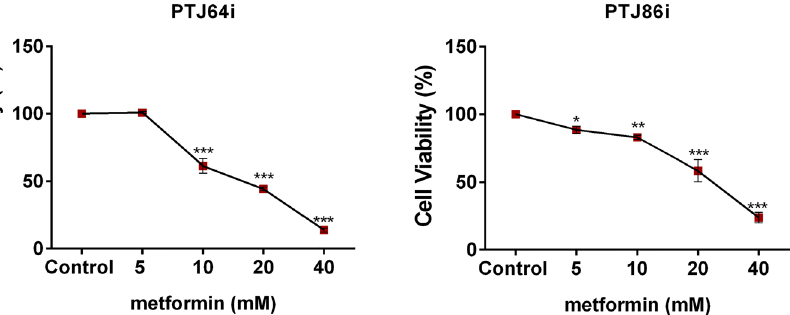
Figure 7. Metformin affects cell viability in PTJ64i and PTJ86i cell lines. Cells were incubated for 72 hours with metformin at the indicated concentrations, or with PBS vehicle (control). Cell viability was assessed by MTT assay. Metformin significantly inhibited cell viability in both cell lines in a dose-dependent manner, with an IC 50 of 21.6 mM in PTJ64i and 22.1 mM in PTJ86i, as assessed by CompuSyn. Data shown are the means ± SD of three independent experiments with quintuplicate determinations. * Statistically significant differences between control and each drug concentration ( * p < 0.05; ** p < 0.01; *** p <